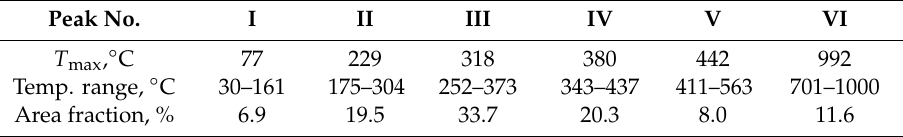
Figure 3. Peak deconvolution of the DTG curve at 10 °C/min. Table 3. Deconvolution peak Table 3. Deconvolution peak characteristics.